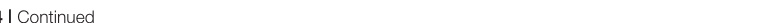
FIGURE 4 | Continued pRNA + RNase. (B) Chemotactic response. Results were expressed as the mean ± ES, n = 7. (C) Expression of CD11b. Results were expressed as the mean ± ES of the relative fluorescence (RF) of the MFI of the different treatments with respect to untreated PMN, n = 7. Right panel : Representative histogram of the expression of CD11b in untreated PMN ( − ), or PMN incubated with pRNA, eRNA, and pRNA + RNase. (D) ROS generation. Results were expressed as the mean ± ES, n = 8. Right panel : Representative dot-plots of the percentage of DHR + PMN incubated with pRNA, pRNA + RNase, or eRNA. (E) NETs formation. Results were expressed as the mean ± ES, n = 9. Inset: Elastase activity for untreated PMN (-), or pRNA, pRNA + RNase, and eRNA treatments. Results were expressed as the mean ± ES, n = 9. Right panel : Representative microphotographs of confocal images showing PMN from pRNA, pRNA + RNase, and eRNA groups stained for DNA or elastase visualization and the merge of the images (x200). In all cases * p < 0.05 vs. all other